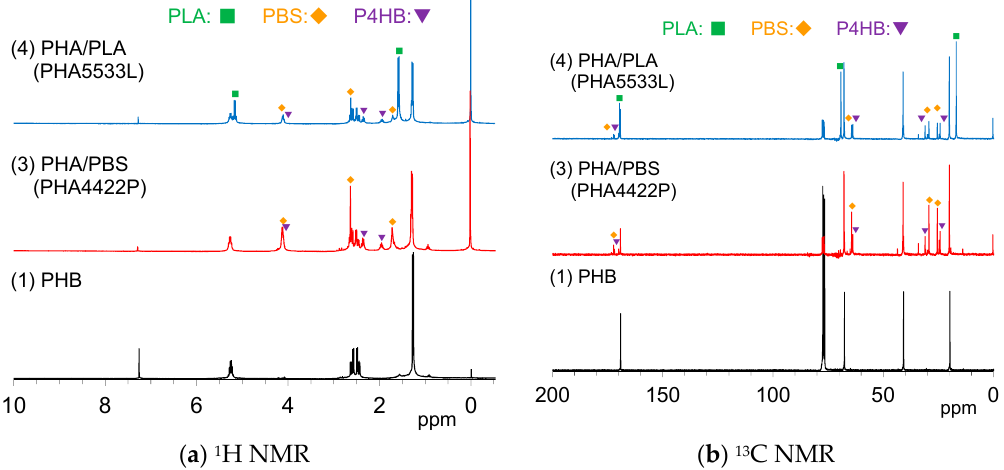
Figure 1. Solution nuclear magnetic resonance (NMR) spectra of plasticized polyhydroxyalkanoates (PHA) copolymers and original poly(3-hydroxybutyrate) (PHB) in CDCl 3 .